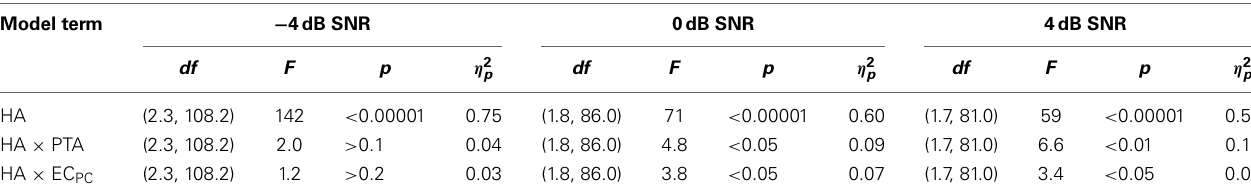
“better RS” subgroups, gray dotted horizontal bars denote significant differences for the “larger PTA” and “worse RS” subgroups, and black dashed vertical bars denote significant differences among pairs of subgroups for a given HA condition ( ∗ p < 0 . 05, ∗∗ p < 0 . 01, ∗∗∗∗ p < 0 . 0001, ∗∗∗∗∗ p < 0 . 00001). HA denotes HA condition.